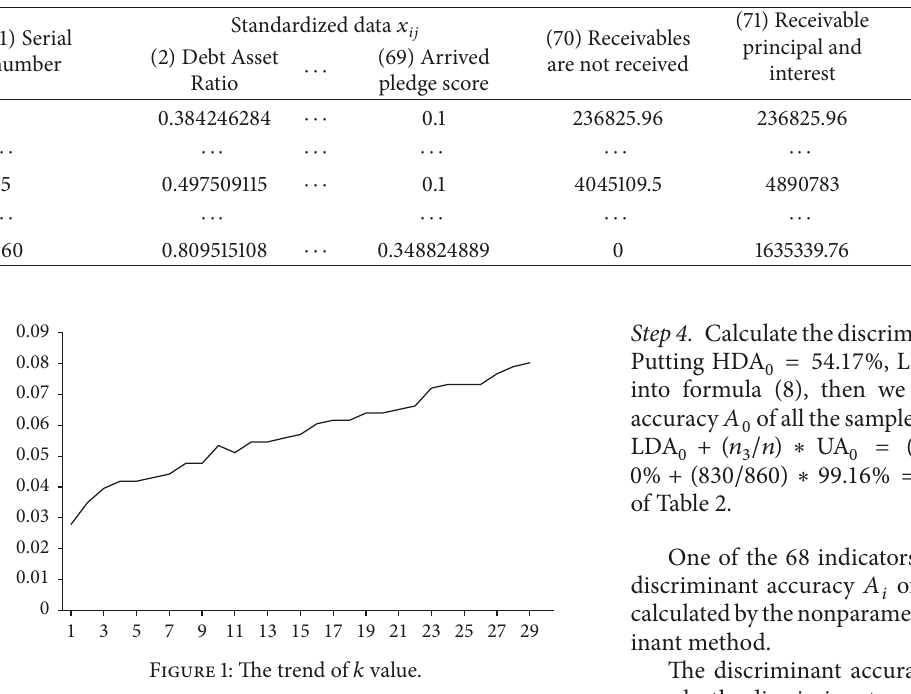
Table 1: Loan data of 860 microenterprise customers.